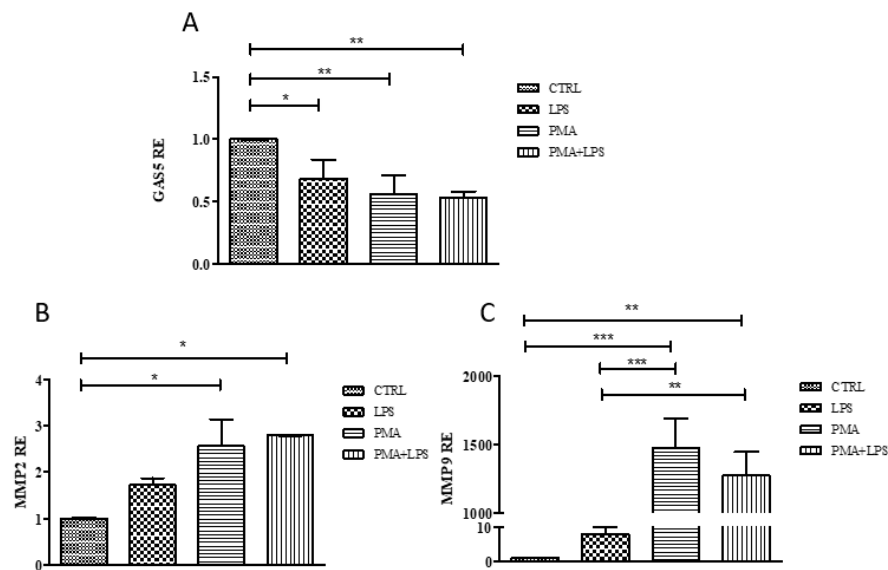
Figure 5. Relative expression (RE, values are expressed as 2 − ∆ Ct ) of GAS5 ( A ), MMP2 ( B ), and MMP9 ( C ) in THP1 cells exposed to LPS (lipopolysaccharide), PMA (phorbol-12-myristate 13-acetate), and PMA + LPS. GAS5 , MMP2 , and MMP9 expression was normalized using 18S gene. One-way ANOVA